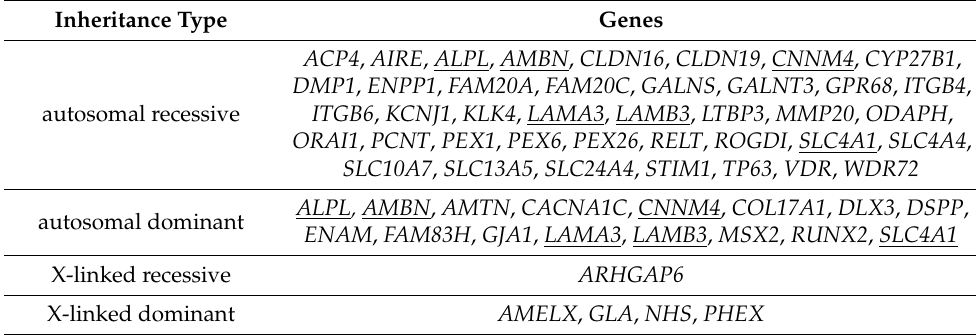
Table 2. Genes per inheritance